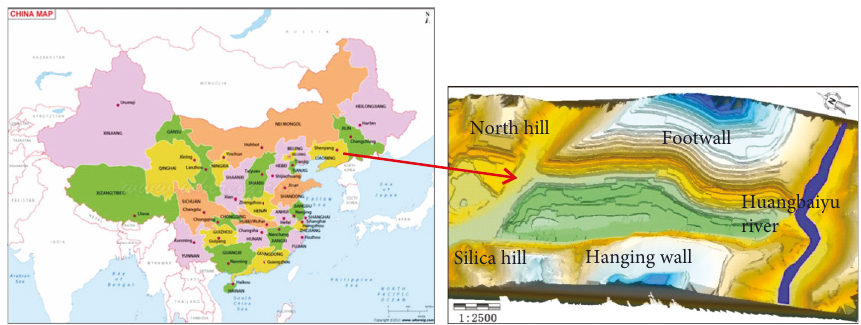
Figure 1: Location and satellite maps of the Nanfen Open-Pit Iron